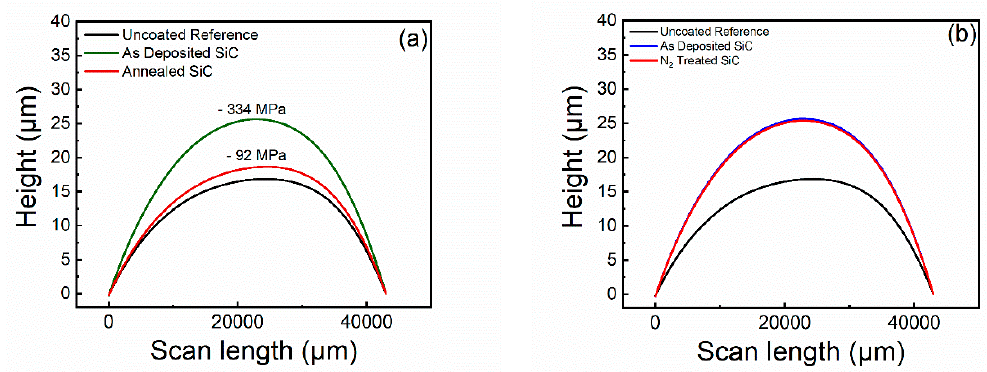
Figure 2. Curvature of a 2” silicon wafer coated before and after depositing 200 nm of SiC followed by ( a ) a post-deposition annealing at 400 °C for 12 h and ( b ) post-deposition plasma treatment with N 2 for 10 min.